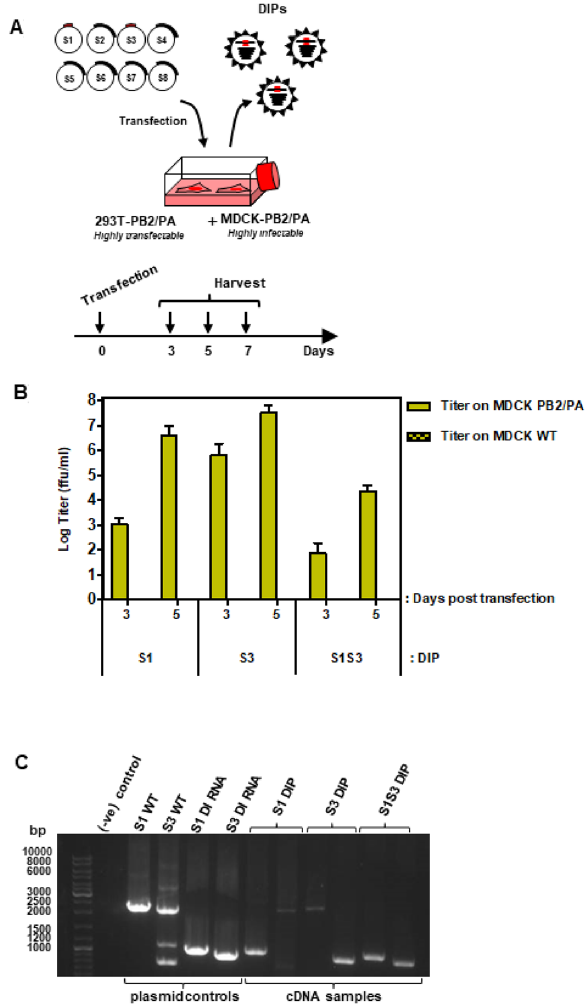
Figure 2. Production of DIPs from complementing cell lines. ( A ) Work flow for production and quantification of DIPs harboring segment 1- and 3-derived DI RNAs. For production of DIPs, a co-culture of 293T and MDCK cells stably expressing at least two IAV polymerase proteins was co-transfected with plasmids encoding WT IAV genomic segments 2 and 4–8 as well as segments 1 and 3 containing internal deletions that convert these segments into DI RNAs. Supernatants were harvested at the indicated time points. (Modified from 15 , URL: https:// journ als. plos. org/ ploso ne/ artic le? id= 10. 1371/ jornal. pone. 02127 57, under the creative commons attributions license link: https:// creat iveco mmons. org/ licen ses/ bi/4. 0/) ( B ) A co-culture of PB1/PB2/PA 293T cells and PB2/PA MDCK cells was transfected with plasmids encoding S1, S3 or S1S3 DI RNAs jointly with the remaining IAV WT genomic segments. Supernatants were harvested on days 3, 5 and 7-post transfection. Titers were determined by focus formation assay using PA/PB2 MDCK cells. The average of three independent experiments is shown. Error bars indicate SEM. ( C ) DI RNA incorporation into DIPs. Supernatants containing DIPs harboring DI RNAs derived from segment 1 (S1) or 3 (S3) or harboring both DI RNAs (S1S3) were analyzed by RT-PCR. Plasmids encoding wt segments S1, S3 or the corresponding DI RNAs served as positive control. A single representative experiment is shown. Results were confirmed in four independent